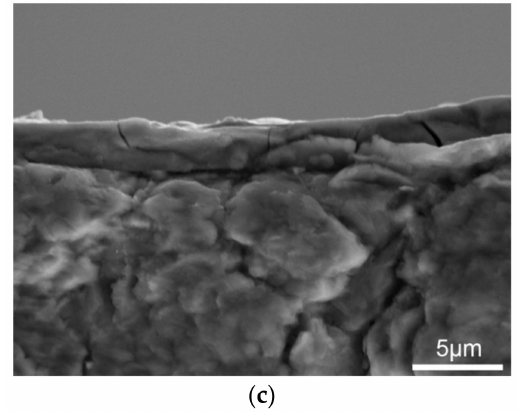
Figure 10. Fracture surface of the CrN coated sample at σ = 725 MPa, 13574 cycles. ( a ) Macroscopic morphology of the fracture surface, ( b ) substrate crack morphology in the white dashed circle of ( a ), ( c ) coating crack morphology under the white arrow of ( b ) at high magnification. The regions of crack initiation, crack propagation, and instant rupture are marked by A, B, and C in ( a ), respectively.